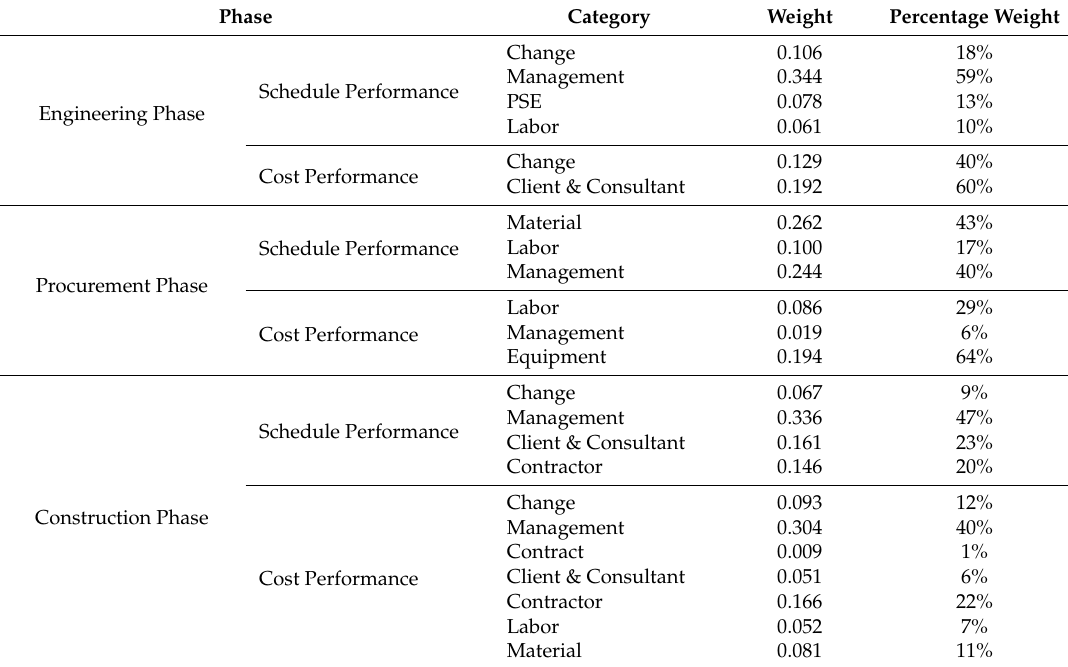
Table 7. Distribution of Significant Key Performance Indicators (KPIs) According to Their